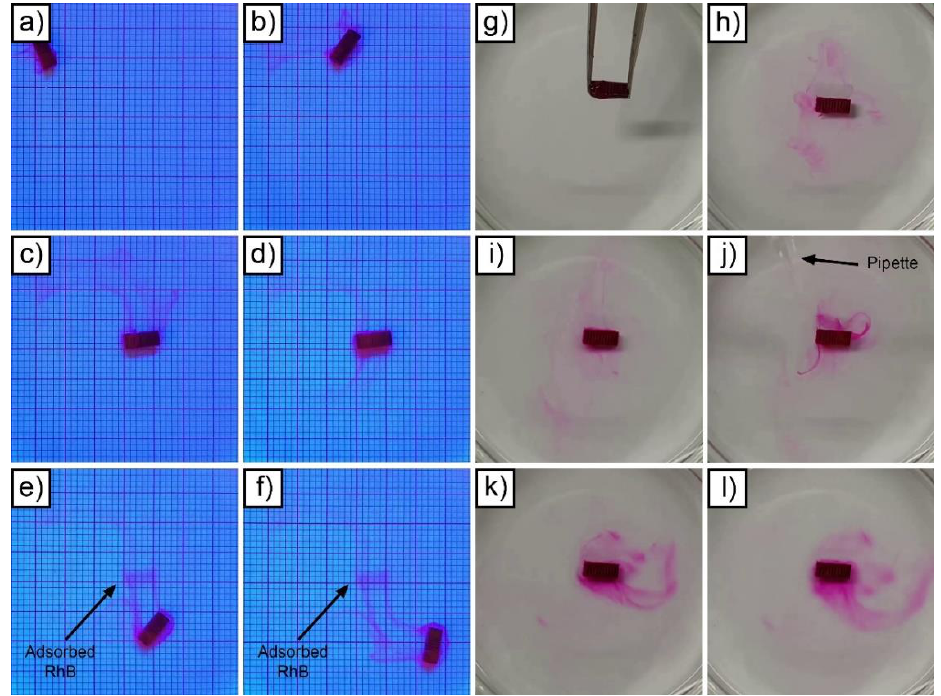
Figure 6. Targeted drug delivery from a device (from ( a – f )); Mn-reticulated hydrogel dissolution test at pH 3 (from ( g – l